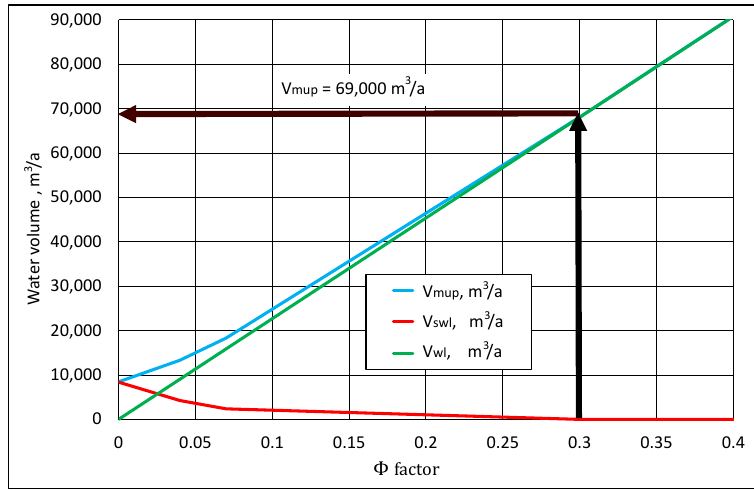
Figure 13. Diagram of changes in loss of mains water in relation to changes in DHS tightness. The items marked on the diagram are as follows: volume of water leaking from the heating system (during the year) as a result of leaks ( V wl —green line); volume of make-up water supplementing the DHS during the year ( V mup —blue line); excess water volume—secondary losses ( V swl —red line). Figure 11 refers to a DHS that is not equipped with an excess water storage tank or thermal energy storage.